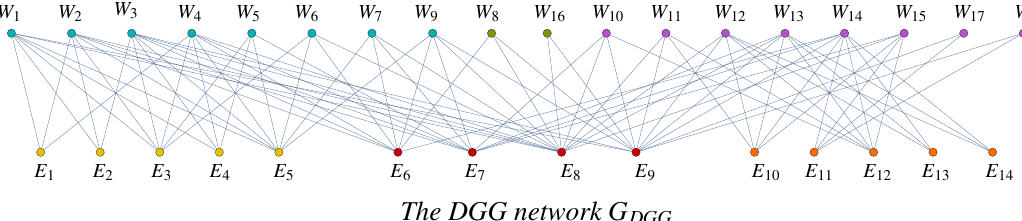
Fig. 7 A graphical realization of the DGG network G DGG where there is an edge between W i and E j if W i attended E j . Following Freeman and Duquenne [34], yellow and orange vertices represent the first and second set of group events E = { E = { E } and E } , respectively. Red vertices represent the joint meetings J = { E 1 1 – E 5 2 10 – E 14 and green vertices represent the first, second, and third groups of women G 1 = { W 1 – W 7 , W 9 } , G 2 = { W 10 – W 15 , W 17 , W 18 } , and G 3 = { W 8 , W 16 } , respectively.